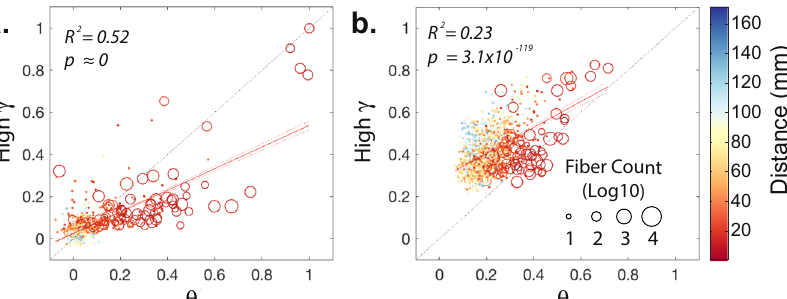
Fig. 3 Cross-frequency similarity of the estimated functional interactions. a Normalized weights of pairwise MEM interaction matrices, J ij , estimated from the lowest (i.e., θ ) and highest (i.e., high γ ) frequency bands for a representative patient (#5). Edges from the interaction matrices with corresponding direct anatomical connections are marked by ‘ o ’ and their size indicates the number of estimated streamlines between each pair of regions. The functional edges without any detected anatomical connections are marked by ‘ . ’ . Edges are color-coded based on the pairwise Euclidean distance between recorded brain regions. Red line represents the linear fi t to the scatter plots (slope = 0.51 and intercept = 0.02 in panel a , slope = 0.61 and intercept = 0.28 in panel b ) and each dashed red lines represent the 95% con fi dence interval. b Co-activation rates calculated from the same patient ’ s binarized band-passed power amplitude states at the lowest (i.e., θ ) and highest (i.e., high γ ) frequency